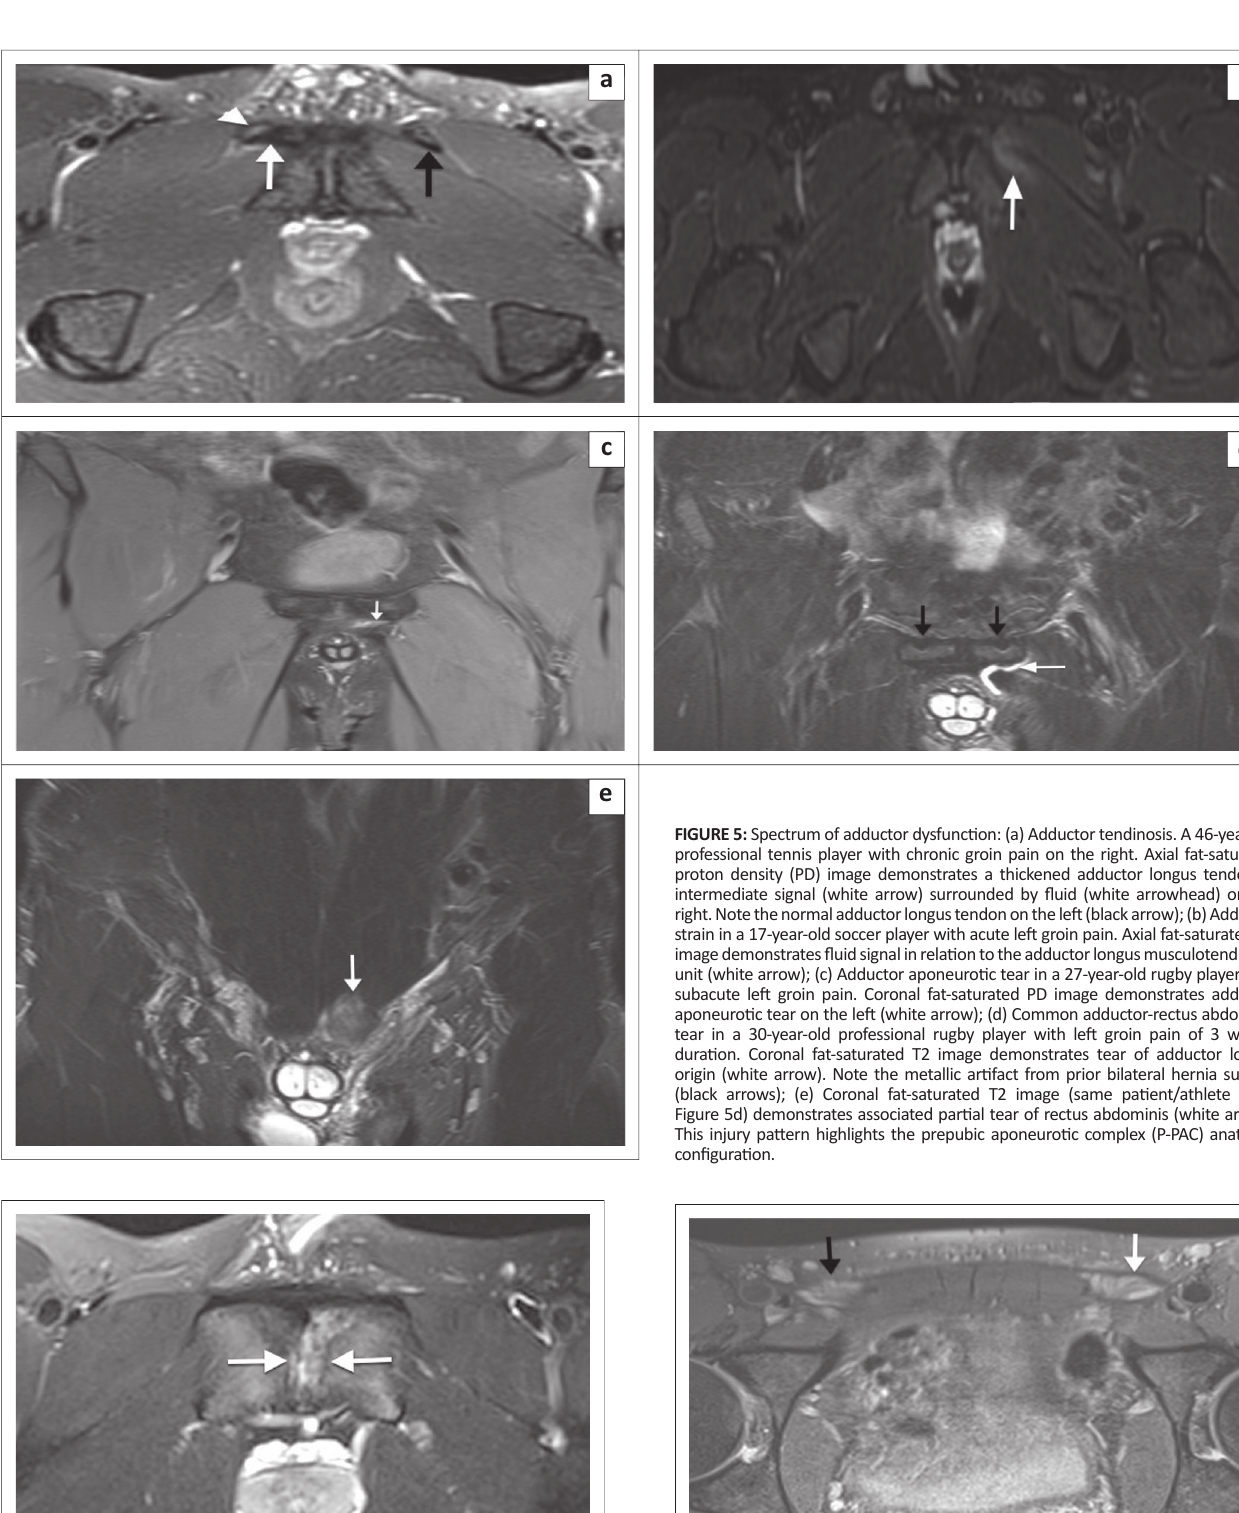
FIGURE 7: Anterior inguinal wall deficiency. A 35-year-old professional male rugby player presenting with right-sided groin pain. Axial fat-saturated proton density (PD) image demonstrates an external oblique aponeurosis tear on the right (black arrow) that was surgically confirmed. Note the intact aponeurosis on the left (white